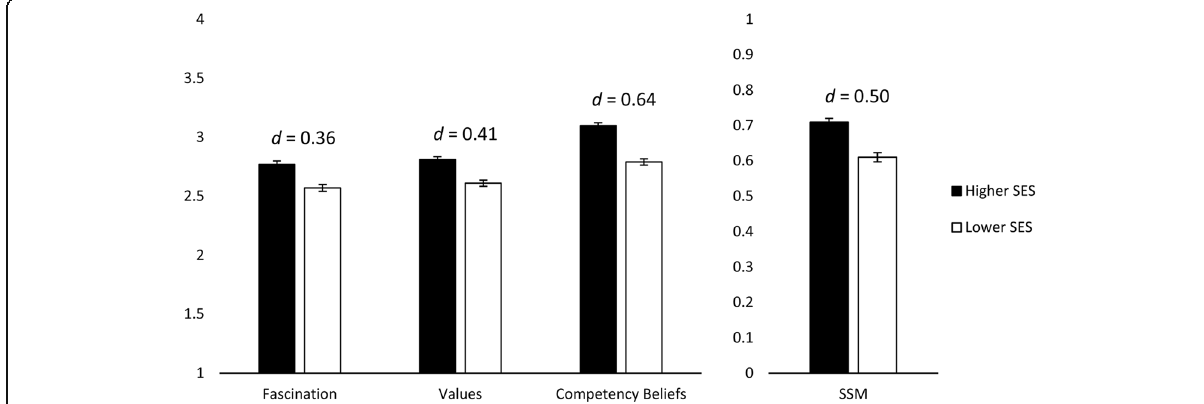
Fig. 2 End of summer means, standard errors, and Cohen ’ s d for science fascination, values, competency beliefs, and scientific sensemaking scores for the higher SES and lower SES groups, controlling for pre-summer